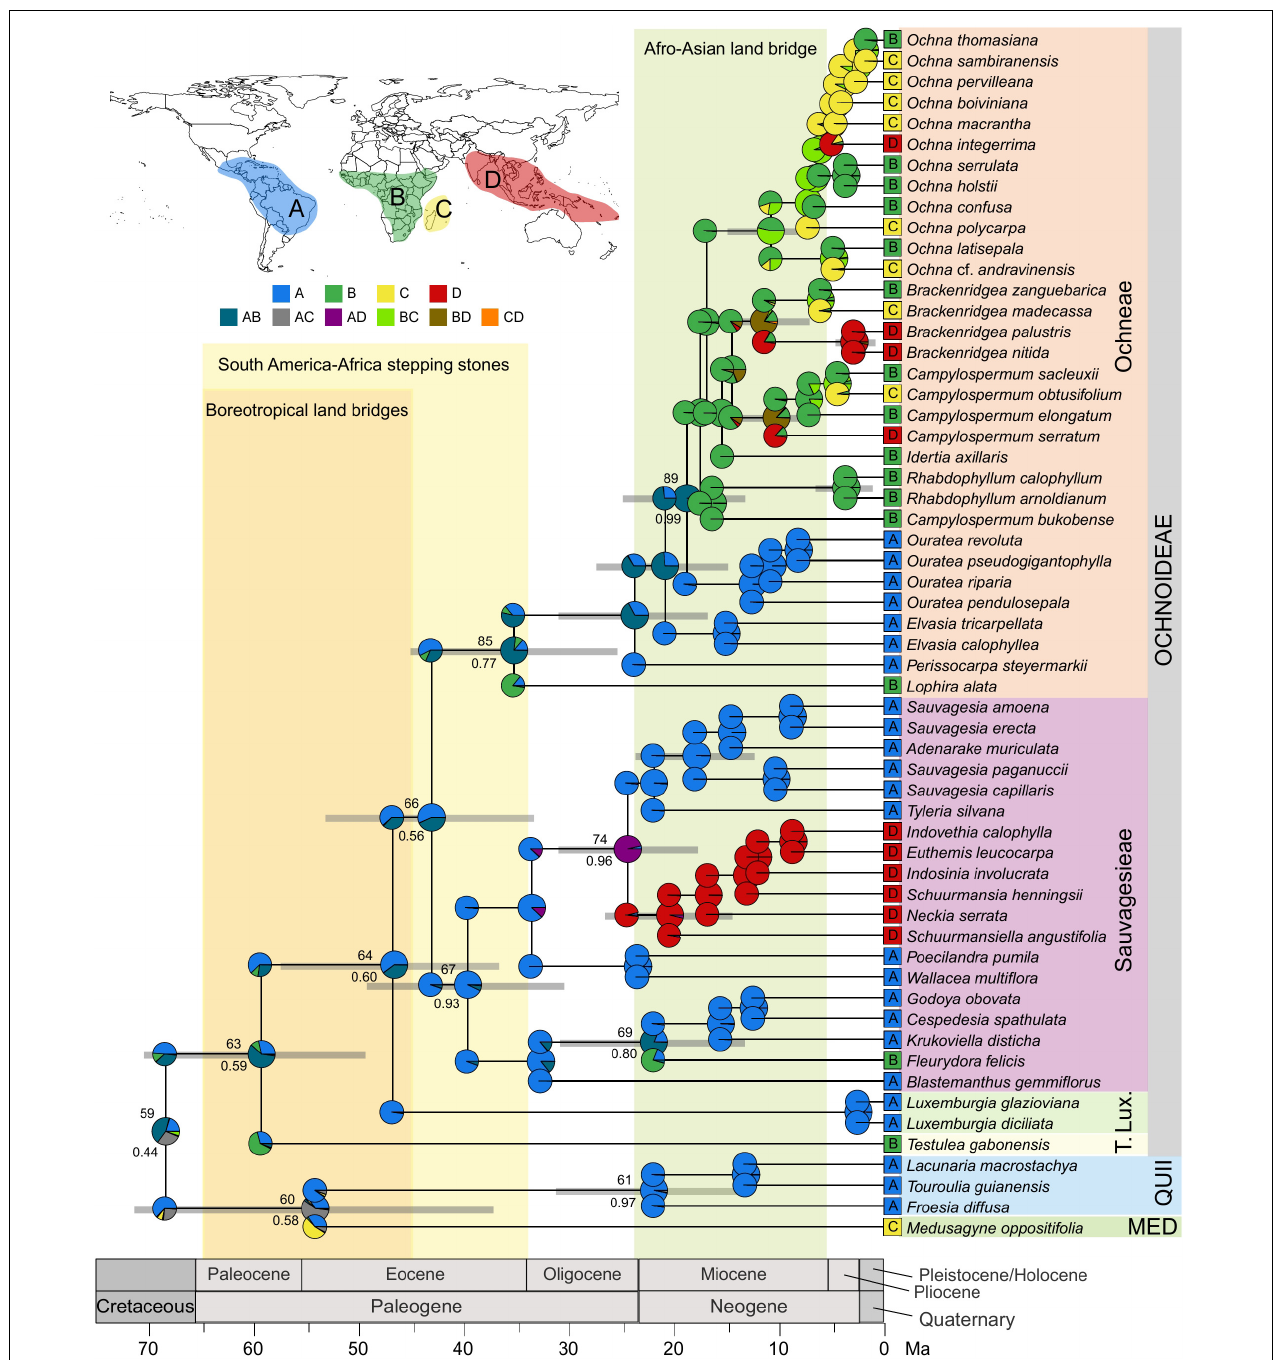
FIGURE 1 | Ancestral range estimation of Ochnaceae. The biogeographic reconstruction under the unconstrained DEC model (max. number of areas = 2; dispersal = 0.0045, extinction = 0.0023) visualizes multiple LDD events which in part can be linked with putative past land bridges (North Atlantic land bridge, Afro-Asian land bridge) or stepping-stone dispersal between South America and Africa (vertical bars show the periods when they were supposed to be extant). The pie charts indicate alternative ancestral geographical ranges and their probabilities. The pie charts on the descendant branches show the ranges immediately after the speciation event, whereas the pie charts on the nodes display the range changes along branches before the speciation event. Numbers below branches are for the ancestral range that received that highest probability (only given for selected nodes), numbers above branches correspond to the node numbers in Supplementary Figure 5 and Supplementary Table 4 containing the complete list of probabilities. Species were assigned to the four distribution areas A to D as illustrated on the inset map and the respective tip ranges (colored squares with letter codes at tips). The legend below the inset map displays the color codes for each area, including the area combinations as retrieved in the analysis. The classification system for Ochnaceae is based on Schneider et al. (2014); Lux., Luxemburgieae; MED., Medusagynoideae; QUII, Quiinoideae; T., Testuleeae.